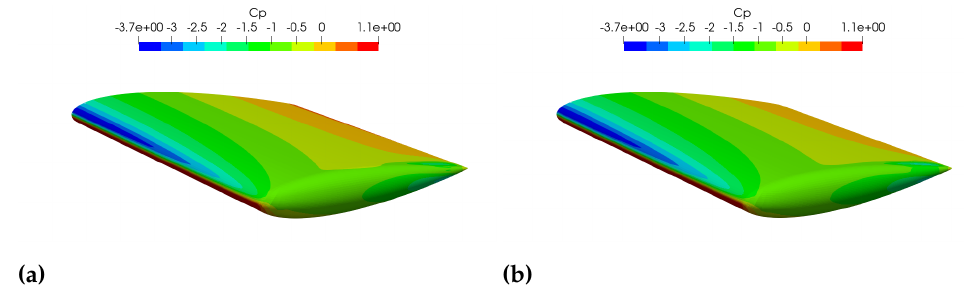
Figure 25. Pressure coefficient distributions as produced by the ( a ) commercial package and ( b ) the current solver